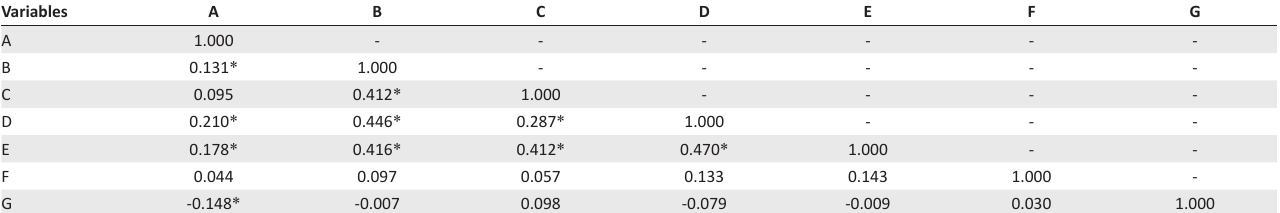
TABLE 1: Relationship between the independent variables and dependent variable.